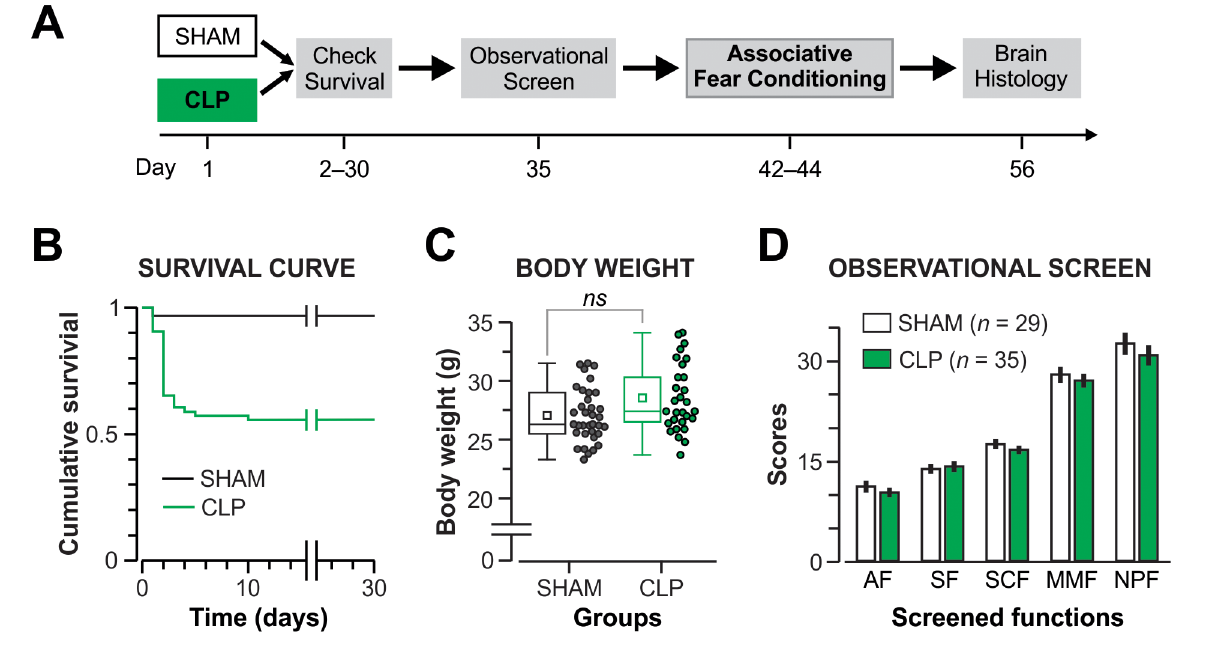
Figure 1. Design of the study. (A) Diagram of the timeline for the experiments in this study. Male C57BL/6 mice are subjected to cecal ligation and puncture (CLP) or sham surgery on d 1, which is followed by the indicated procedures. (B) Kaplan-Meier survival curve showing that some CLP-exposed mice perish within the first week post-surgery before the rest reach a stable survival rate of 56% by d 11. (C) The box plot shows body weights at 35 d post-surgery, which are not significantly different between groups ( P = 0.029, t = 2.24, t test). (D) The graph describes the scores for the functions in the observational screen, as defined in Materials and Methods. All functions are comparable between CLP and sham groups ( P > 0.1 for each function by t test). AF, autonomic function; SF, sensory function; SCF, spinocerebellar function; MMF, muscle and motoneuron function; NPF, neuropsychiatric